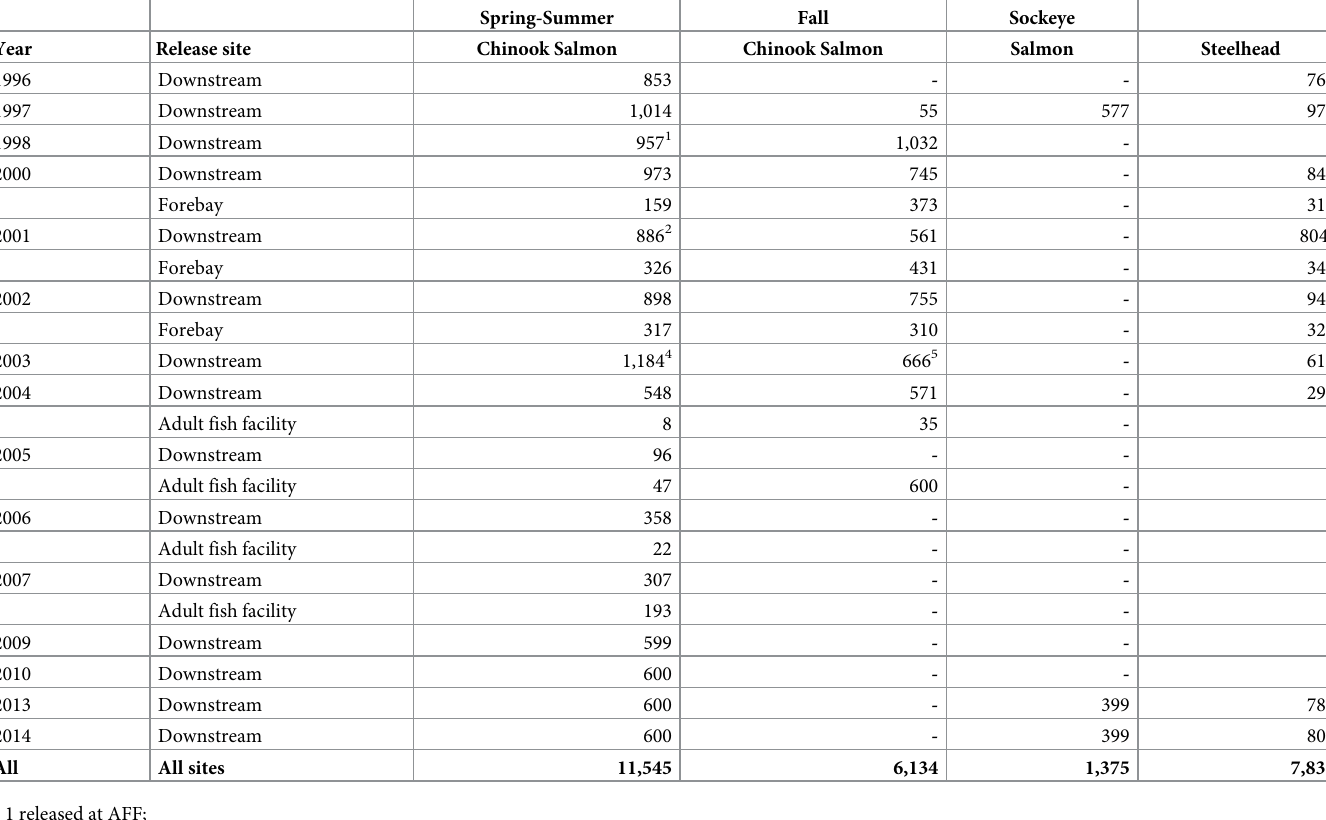
Table 2. Annual numbers and release locations of adult Chinook Salmon, Sockeye Salmon, and steelhead that were collected and radio-tagged at Bonneville Dam Adult Fish Facility (AFF) in